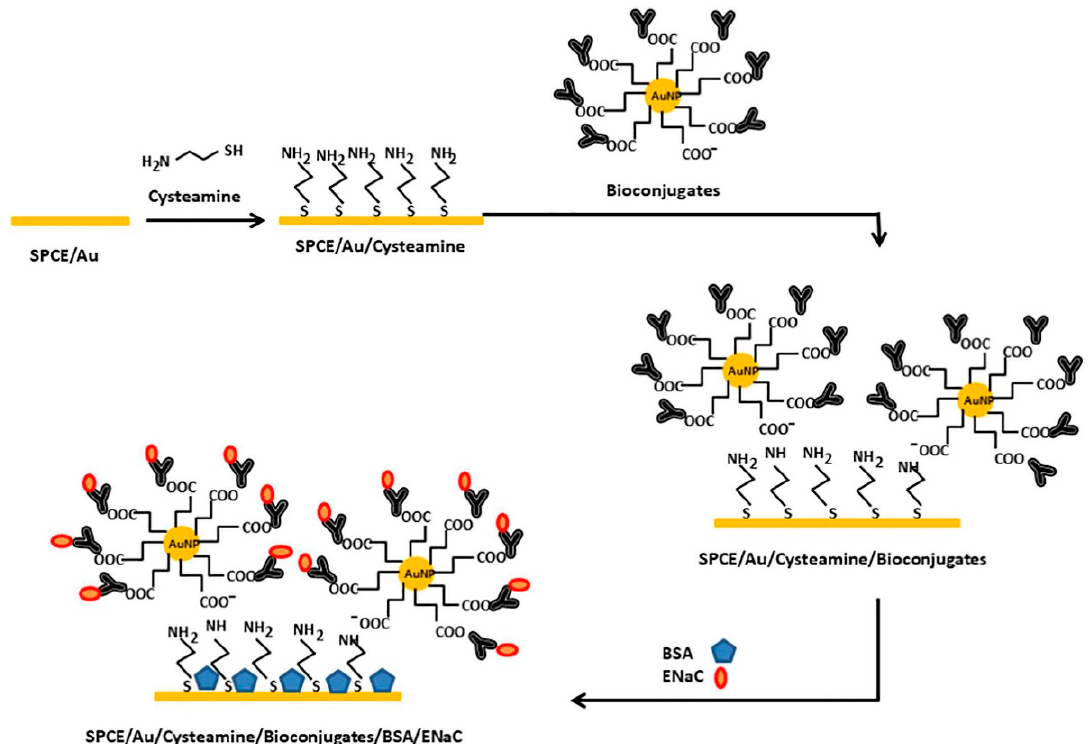
Figure 6. Electrochemical immunosensor for detection of the epithelial sodium channel protein in urine. Au-screen-printed carbon electrodes are used to immobilize AuNPs–antibodies bioconjugates targeting the epithelial sodium channel and used in voltametric measurements. Image adapted from [62] with permission of Elsevier, 2020.